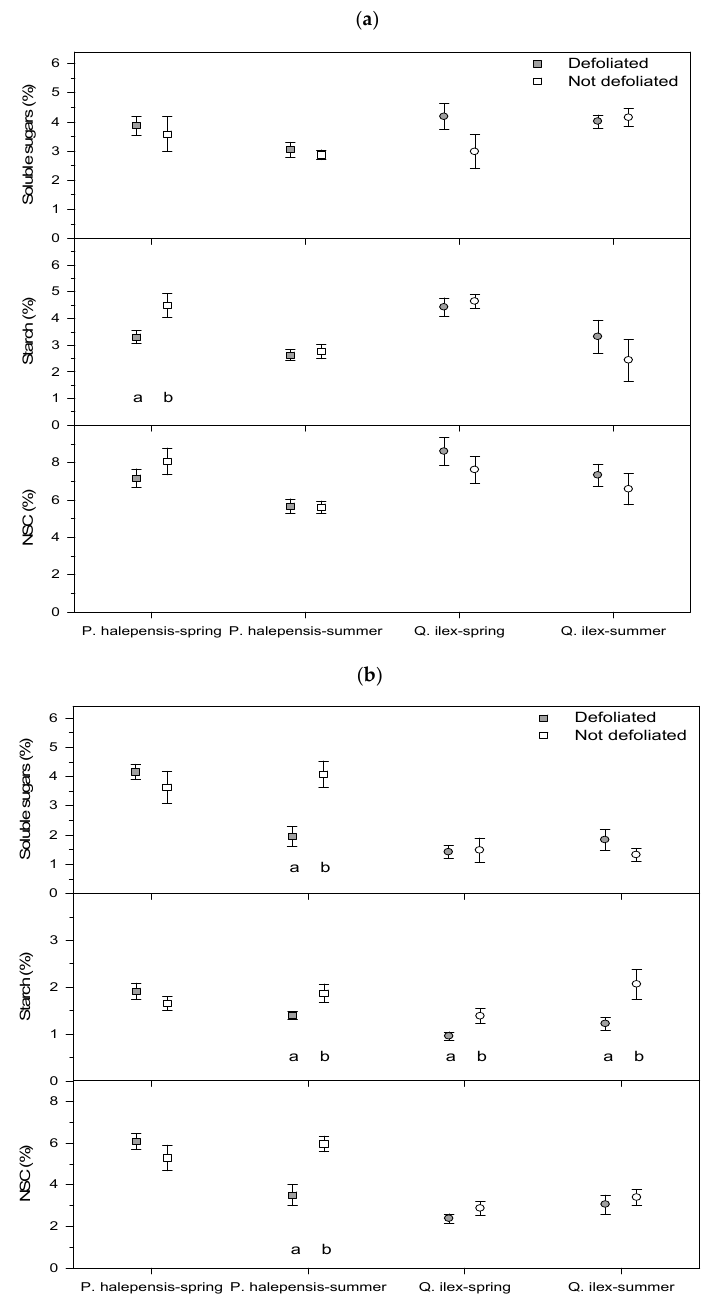
Figure 6. NSC concentrations in ( a ) leaves and ( b ) sapwood of P. halepensis and Q. ilex sampled in spring and summer 2021. Values are means ± SE. Different letters indicate significant ( p < 0.05) differences between defoliated and non-defoliated trees within each date (Mann–Whitney tests).